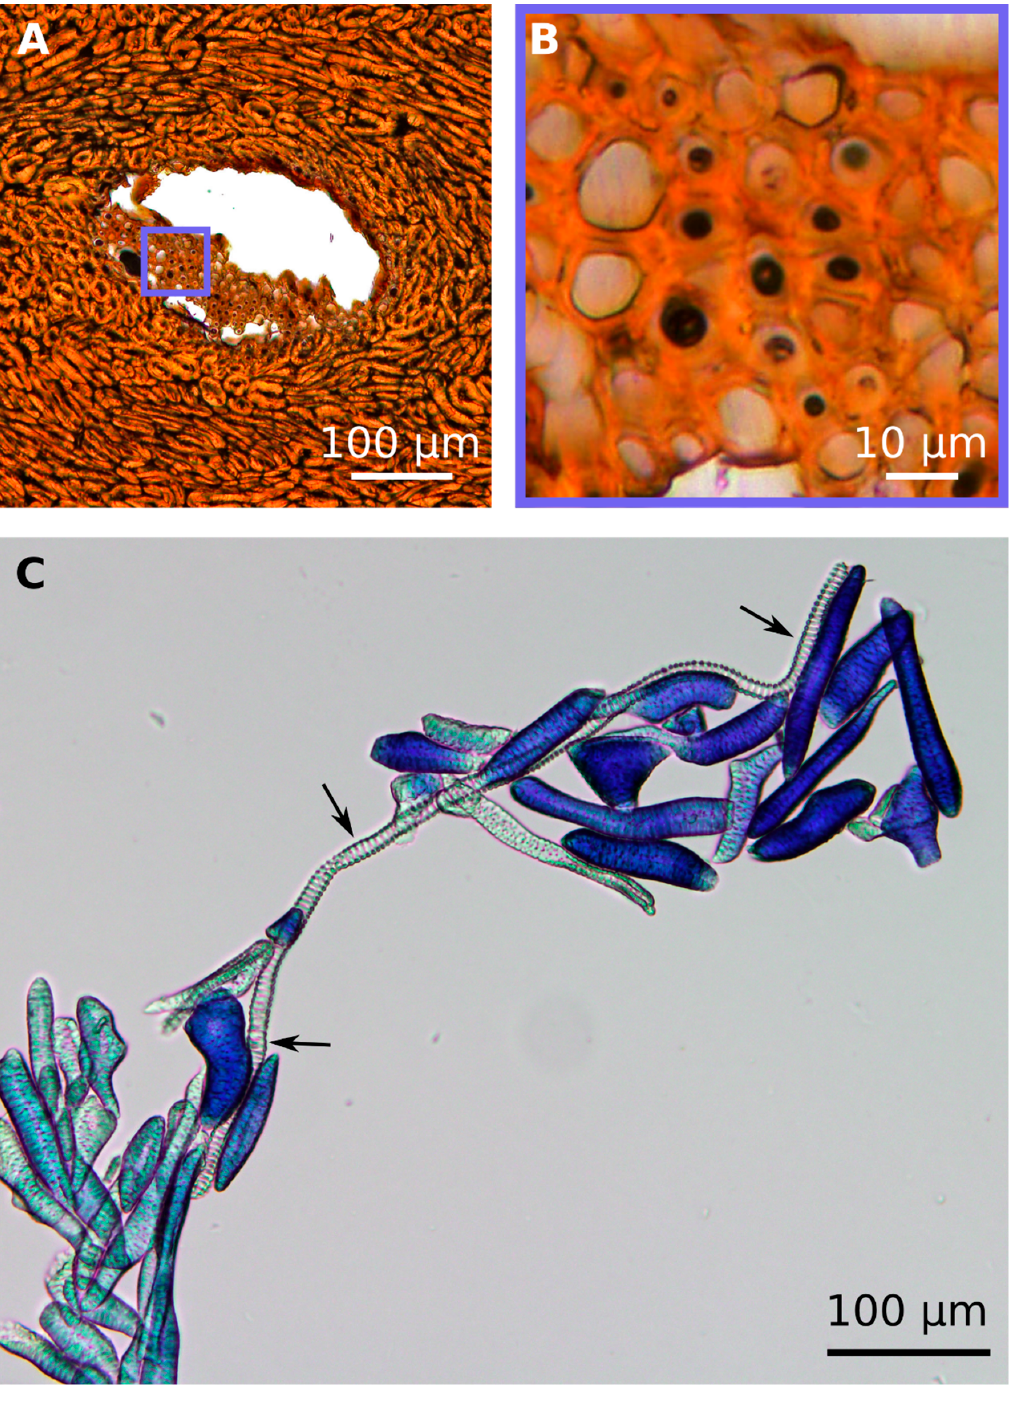
Figure 3. LM images from the coconut endocarp showing tracheids. In the cross section of a vascular bundle (( A ), polished thin section), the polygonal shape of tracheid cross-sections is visible ( B ). Macerated endocarp cells stained with Toluidin blue, showing an intact tracheid cell ( ⟶ ) with a length of 627 µm between accumulated sclereid cells ( C ).